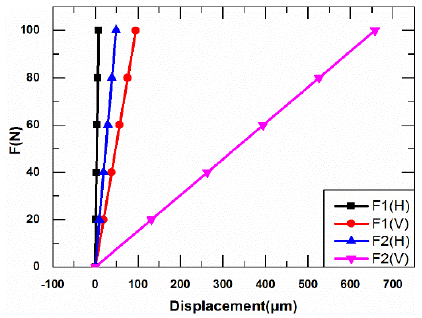
Figure 10. Relationship between the force and displacement.